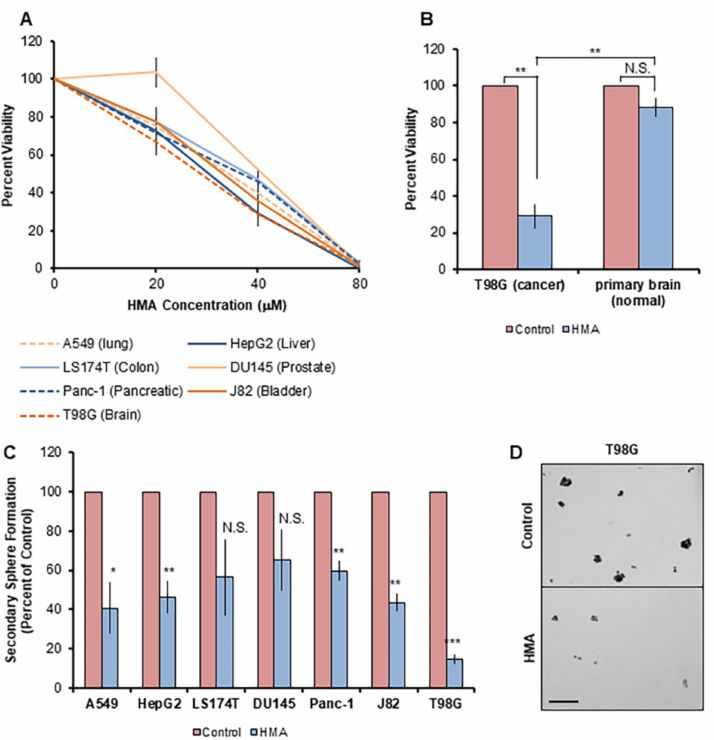
Figure 5. HMA depletes CSCs derived from an array of human tissue types. ( A ) The viability of human tumor cell lines treated with varying concentrations of HMA for 24 h was assessed by trypan blue exclusion assay. Data are presented as averages of at least three independent biological trials and expressed as a percent of vehicle control. ( B ) T98G glioblastoma cells and non-transformed mouse primary brain glial cells were subjected to 24 h treatment with 40 µ M HMA. Cell viability representa- tive of three replicate trials is normalized to vehicle control. ( C ) Cell lines were treated with vehicle or 40 µ M HMA for 24 h and then subjected to the sphere formation assay. Secondary sphere formation is presented as the average sphere count of at least three independent biological experiments and normalized to vehicle control. ( D ) Representative images of DMSO control and 40 µ M HMA-treated T98G spheres are displayed. Scale bar = 200 µ m. Error bars represent SEM. *, p < 0.05; **, p < 0.01; ***, p < 0.001, by Student’s t